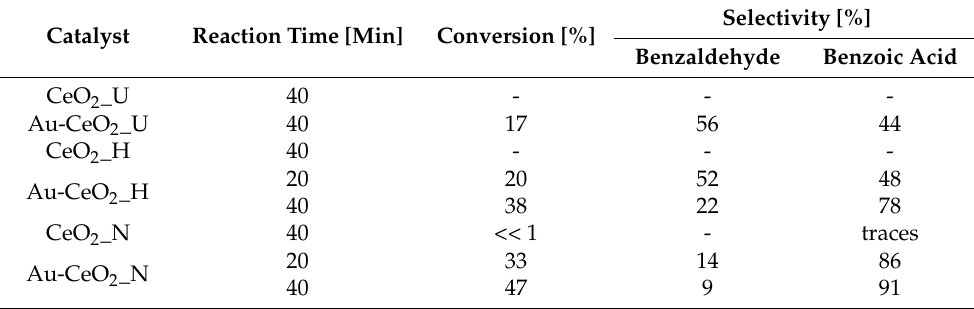
Table 2. Results of benzyl alcohol oxidation at 40 ◦ C 1